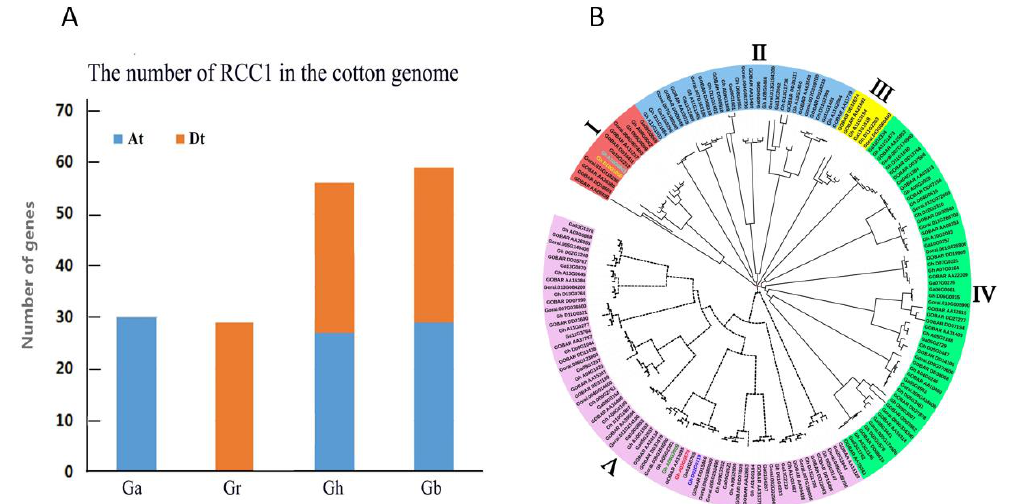
Figure 1. Number and phylogenetic analysis of the RCC1 gene family in four cotton species, G. arboreum (Ga), Gr = G. raimondii , Gh = G. hirsutum , Gb = G. barbadense , At = A subgroup, Dt = D subgroup. ( A ) Comparison of the number of RCC1 genes in four cotton varieties. ( B ) Non-root phylogenetic tree of the RCC1 protein sequence of G. arboreum , G. raimondii , G. hirsutum , and G. barbadense. The full-length protein sequences from several plant species were aligned by CLUSTAL Omega and the phylogenetic tree was built using the adjacency (neighbor-joining) method in the iTOLv4 website. The bootstrap value was 1000